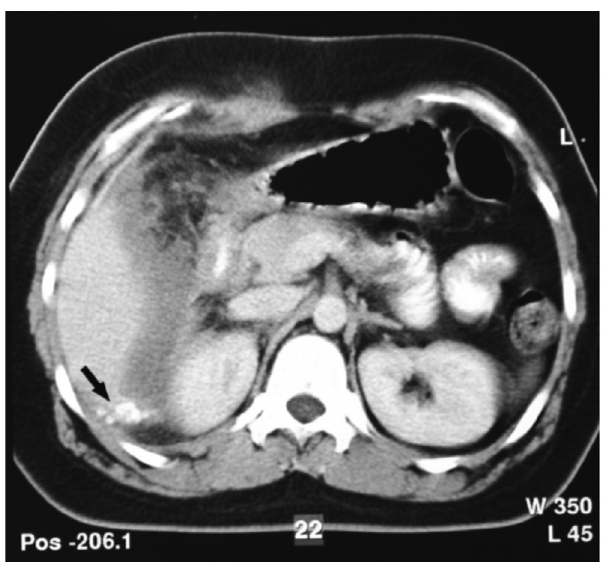
Figure 1 - The computed tomography of the abdomen revealed a complex infra-hepatic abscess (5 x 7 x 9 cm) showing calcified density (gallstones) within the lateral margin